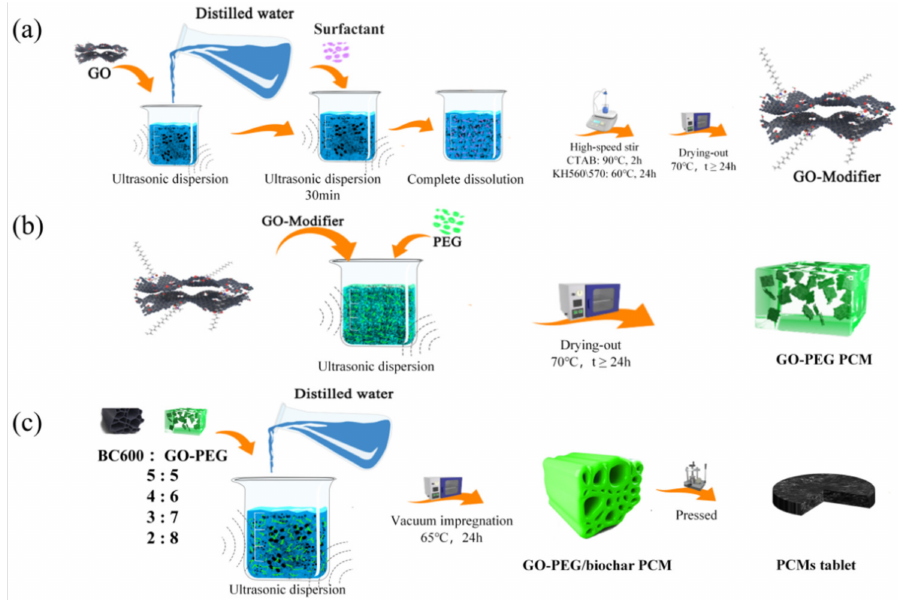
Figure 1. Schematic diagram of the preparation process for ( a ) GO-modifier and ( b ) GO-PEG PCMs ( c ) GO-PEG/biochar